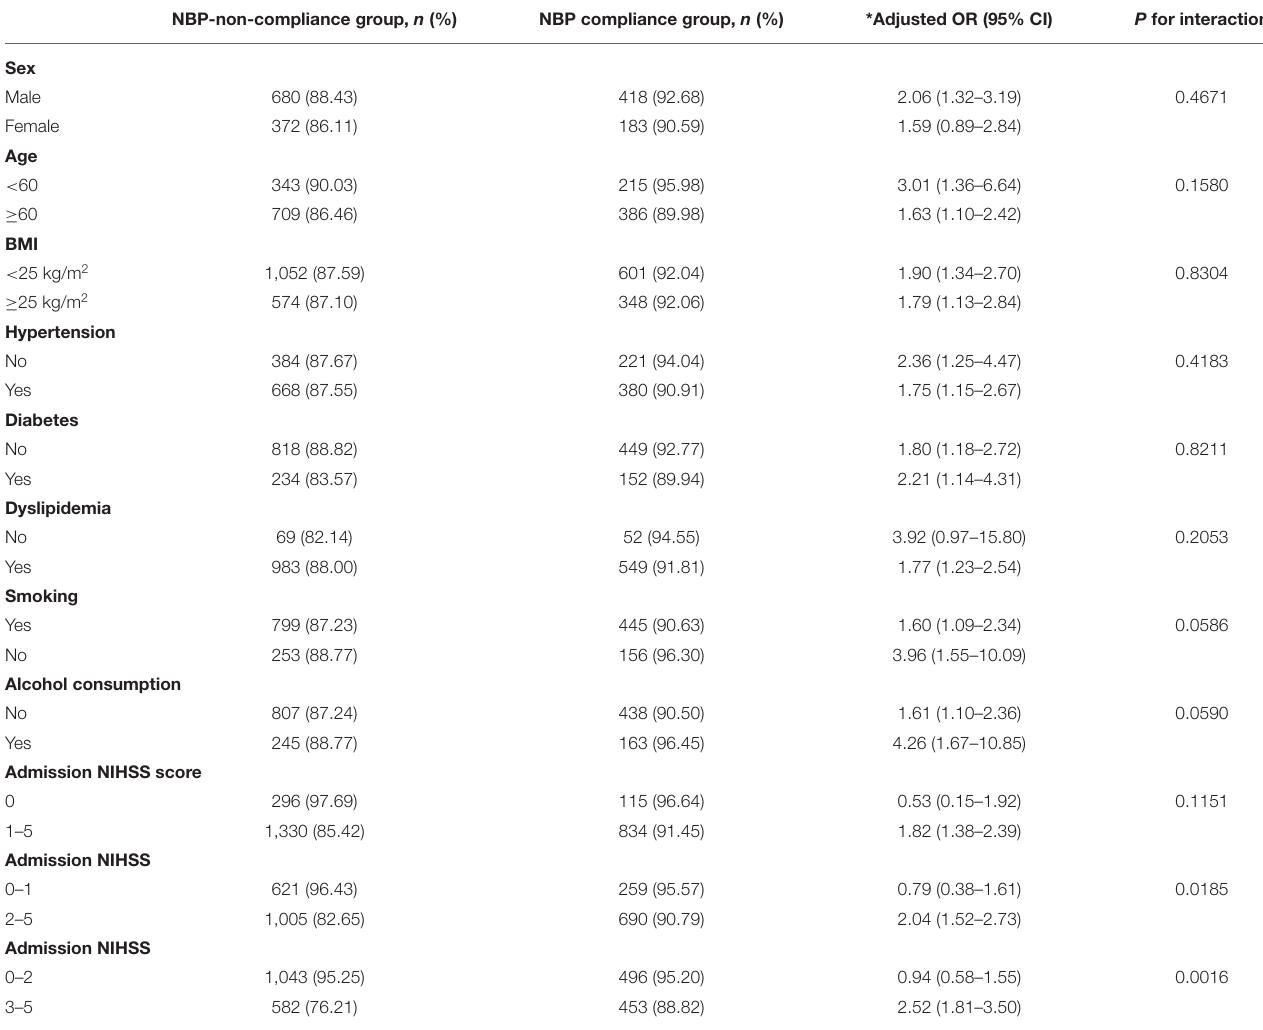
TABLE 3 | Subgroup analysis on favorable functional outcome at 90 days (mRS